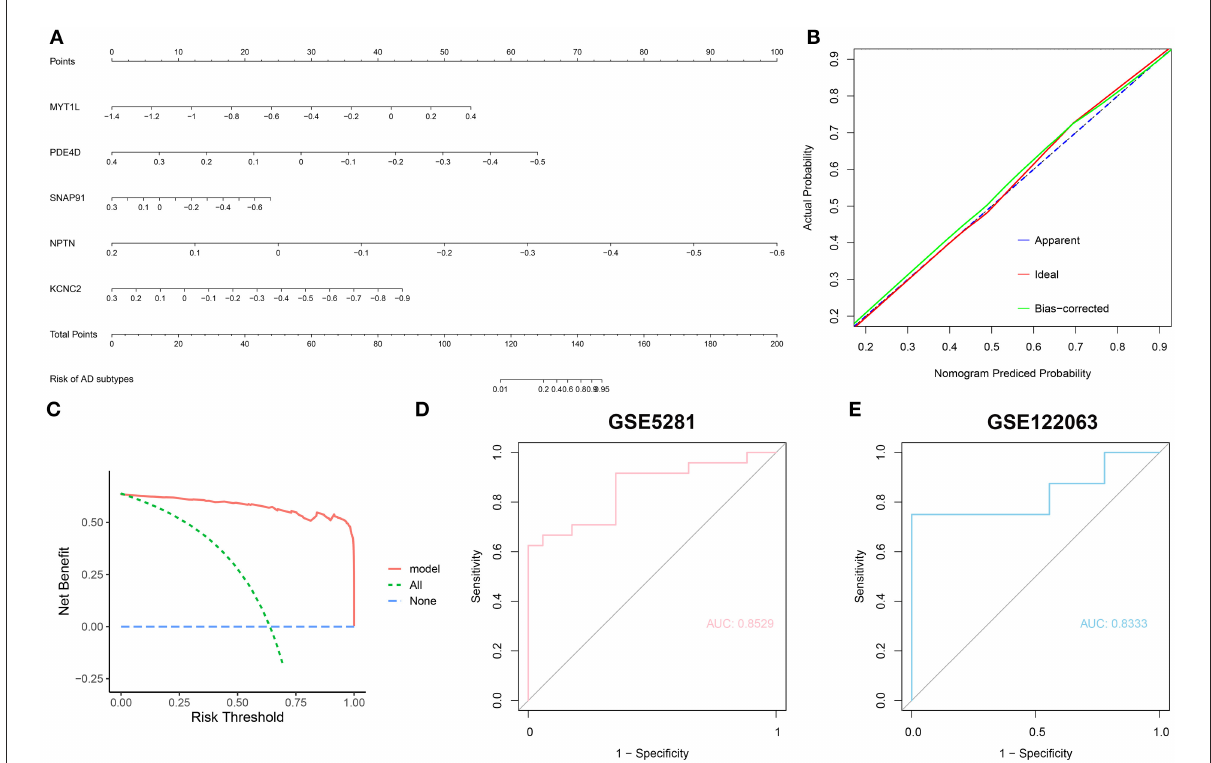
FIGURE9 Validation of the 5-gene-based RF model. (A) Construction of a nomogram for predicting the risk of AD clusters based on the 5-gene-based RF model. (B,C) Construction of calibration curve (B) and DCA (C) for assessing the predictive efficiency of the nomogram model. (D,E) ROC analysis of the 5-gene-based RF model based on 5-fold cross-validation in GSE5281 (D) and GSE122063 (E) datasets.